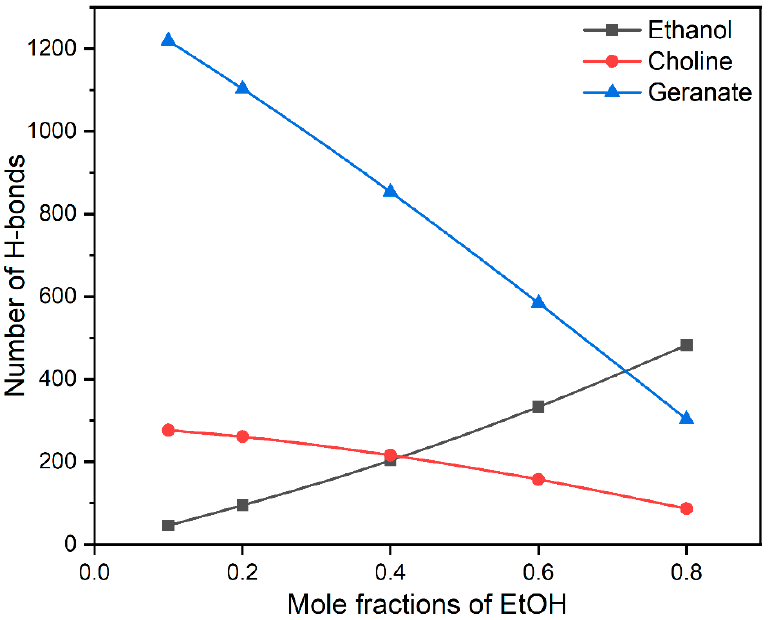
Figure 4. The average H-bonding interactions of ethanol, choline, and geranate with water molecules. The interaction of water molecules are more responsible for the stabilization of